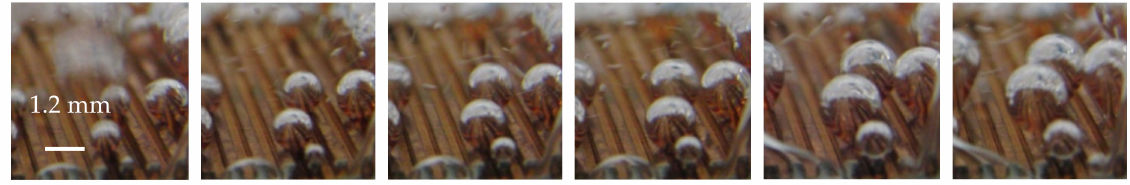
Figure 13. Successive images of growing isolated bubbles boiling on the MC-0.4-0.4-0.8 surface.